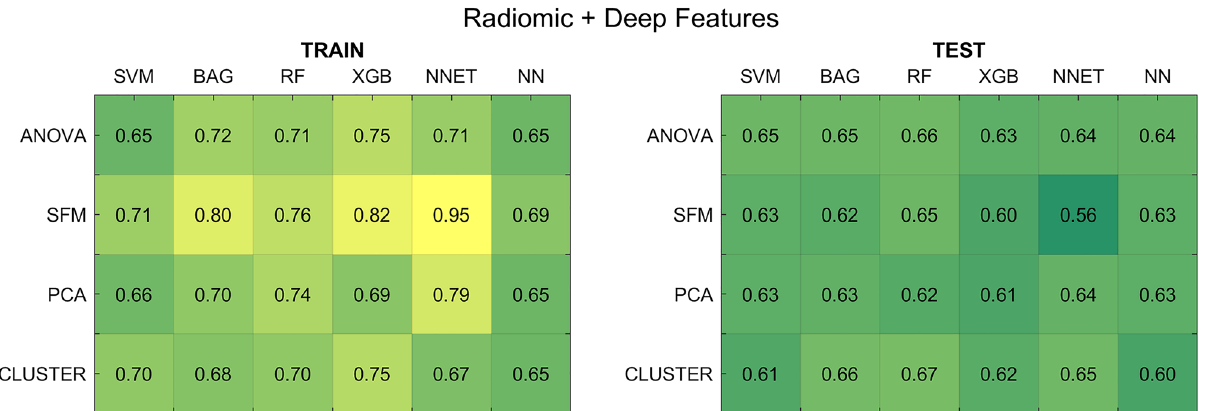
Figure 6. Results for the radiomic and deep feature-based models without including clinical data. (Left panel) Average AUCs on the five training splits. (Right panel) Average AUCs on the test splits. SFM SelectFromModel, PCA principal component analysis, CLUSTER feature agglomeration through clustering, SVM support vector machines, BAG bagging, RF random forest, XGB extreme gradient boosting, NNET neural network, NN k-nearest